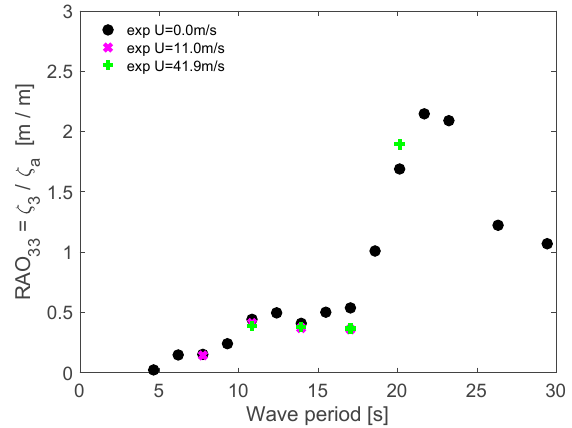
Figure 15. Effect of the incident wind speed on the experimental RAO heave motion results.